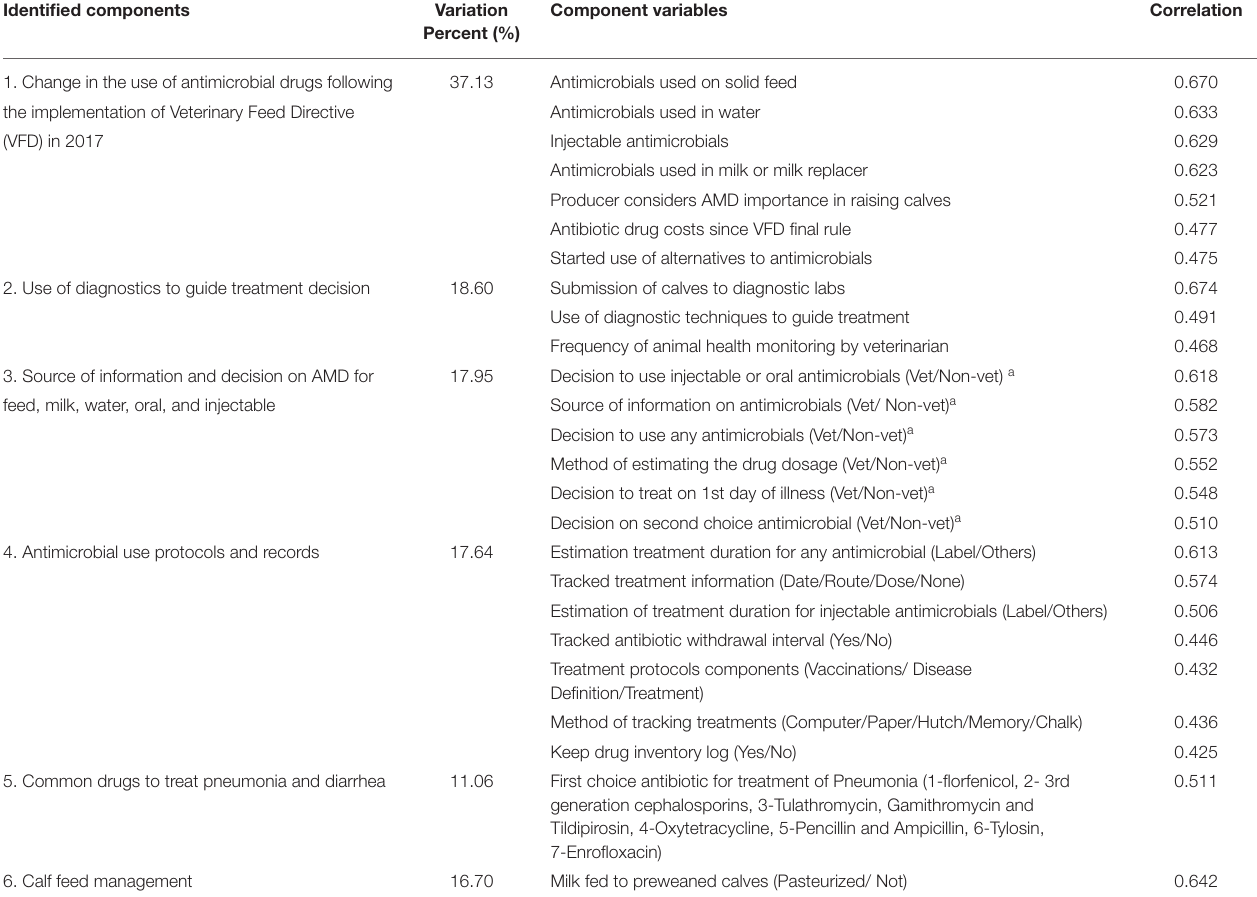
TABLE 11 | Component variables explaining variability in antimicrobial drugs (AMD) in preweaned dairy calves on California dairies. Identified